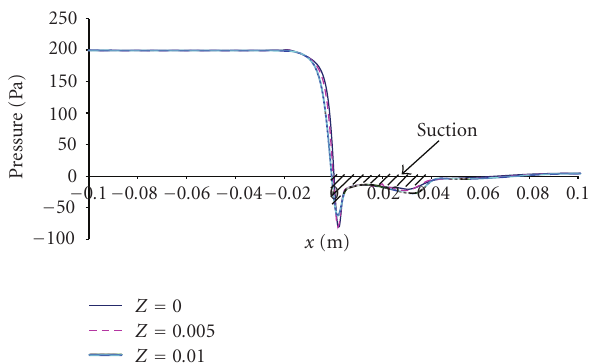
Figure 10: Pressure profile along several axial planes at top wall.